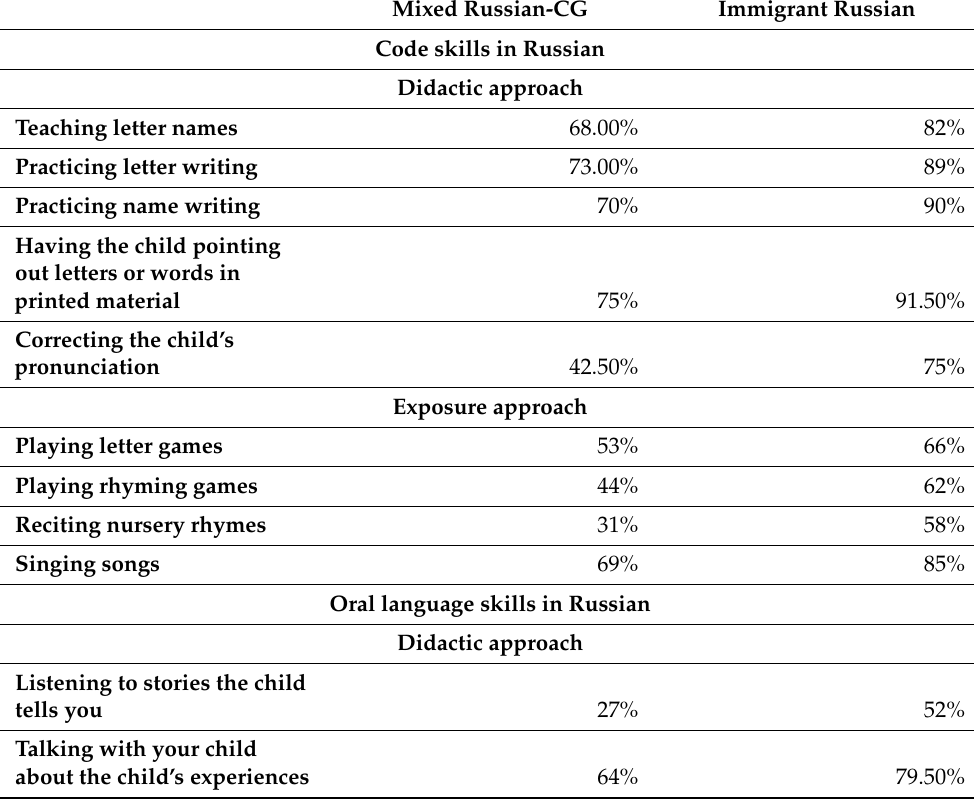
Table 5. Code vs. oral skills/Didactic vs. exposure